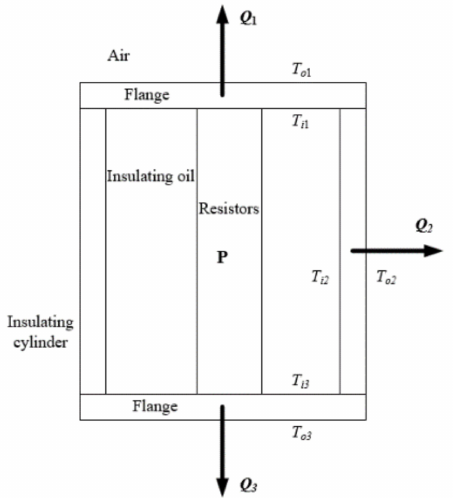
Figure 3. Schematic diagram of heat transfer of the voltage